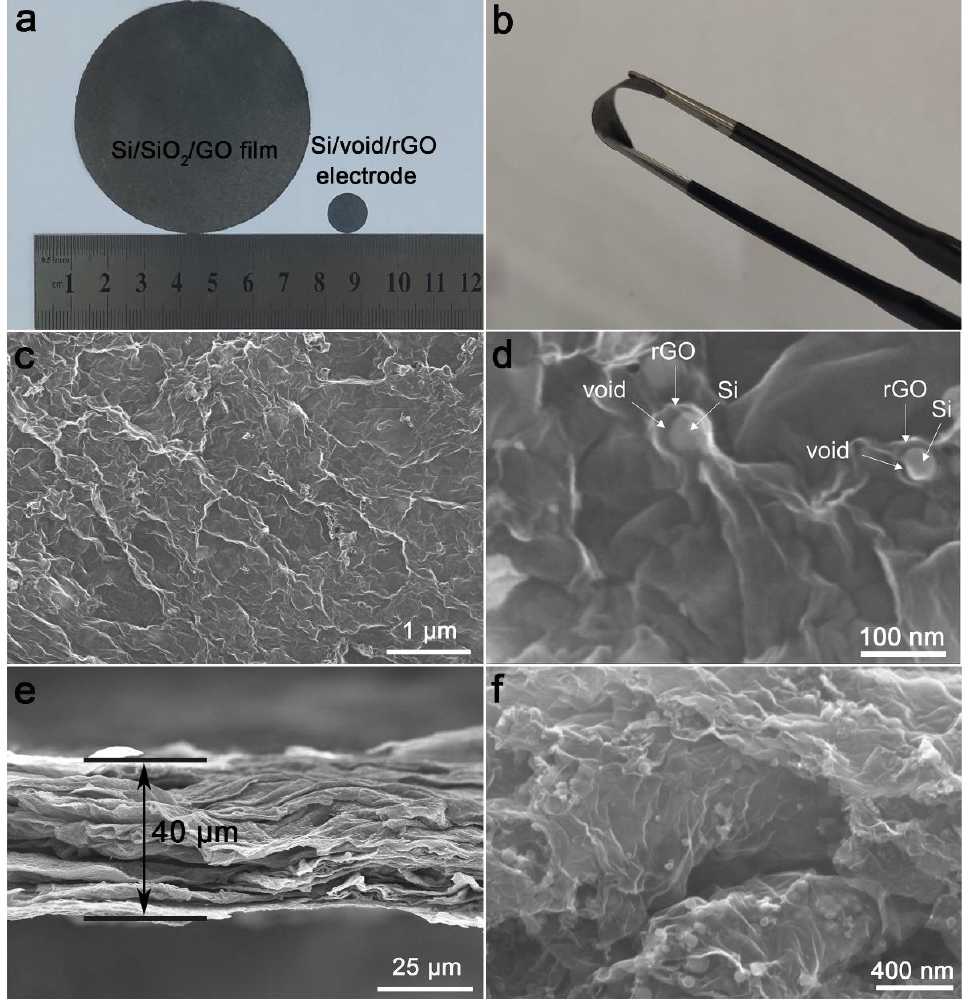
Figure 2. ( a , b ) Photographs of Si/SiO 2 /GO aerogel after compression and free-standing Si/void/rGO electrode; ( c , d ) surface SEM images of the free-standing Si/void/rGO electrode at different magnifications; ( e , f ) cross-section SEM images of the free-standing Si/void/rGO electrode at different magnifications.